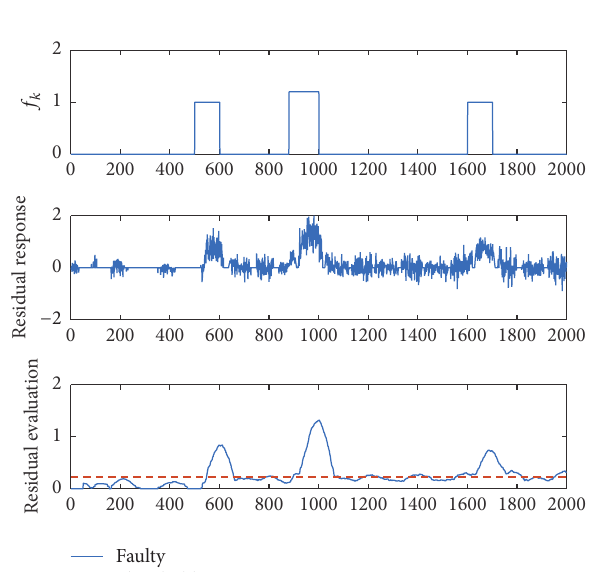
Figure 2: Estimation of states.